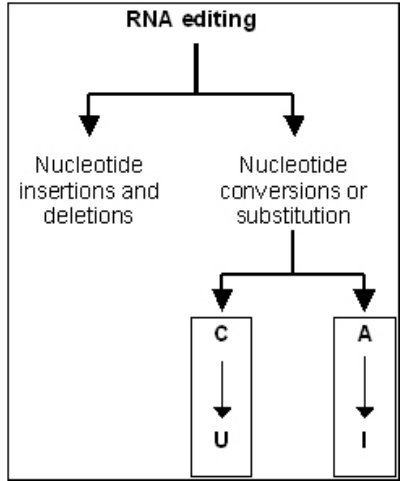
FIGURE 1 . Classes of RNA editing. RNA editing can be grouped under two classes. (1) Nucleotide insertions and deletions: alterations on RNA sequences by the insertion of bases into existing RNA sequences or by the deletion of existing bases. (2) Nucleotide conversions or substitutions: alterations on RNA sequence by converting one base to another. Conversions of cytosine to uracil and adenosine to inosine are the known nucleotide conversions occurring in RNA editing. Adenosine to inosine conversion is caused by ADAR